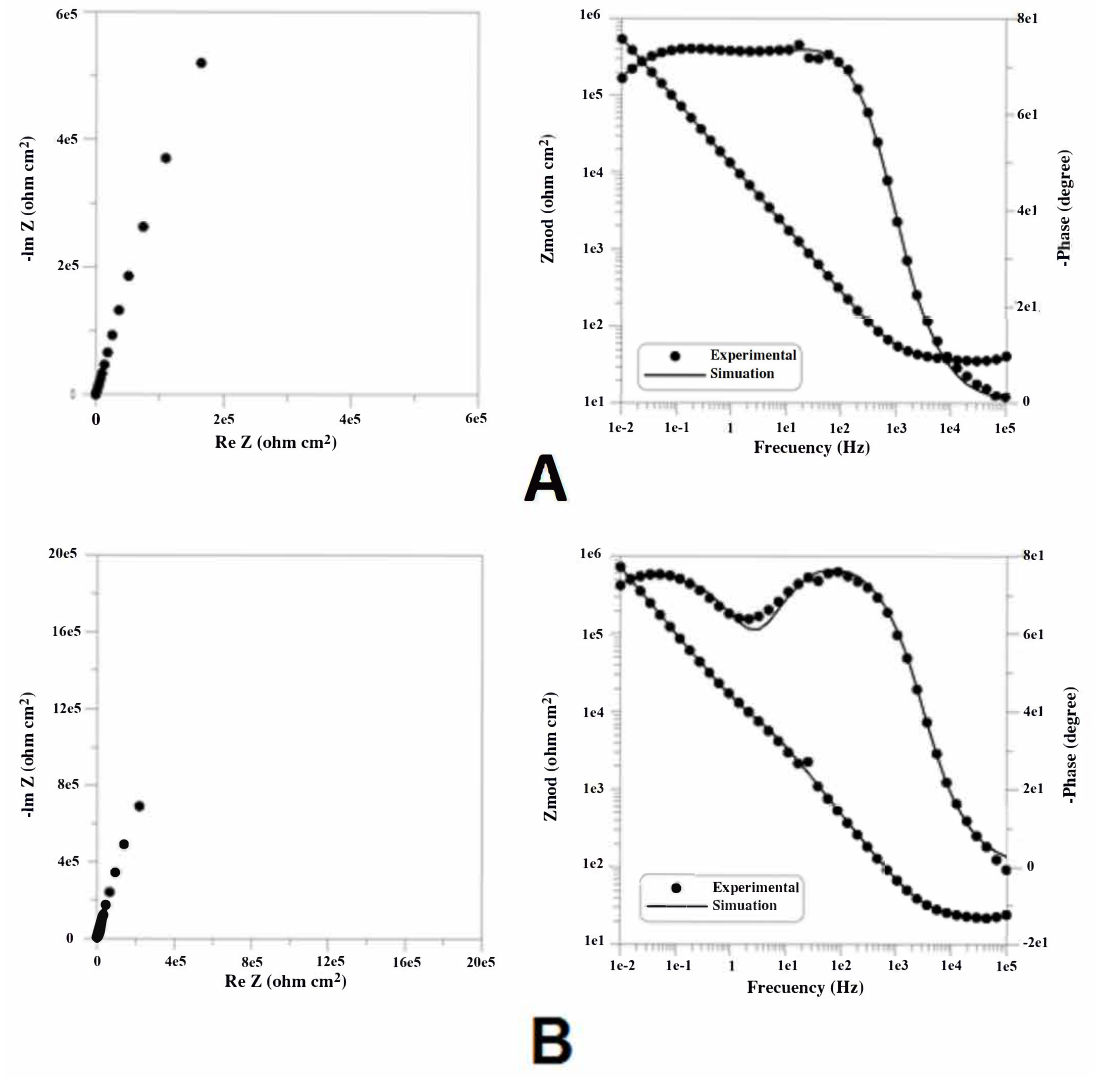
Figure 7. Bode spectra and Nyquist plot diagrams for CoCr-based dental alloys in Ringer solution at a potential of 100 mV/ESC. ( A ) Specimen Co1. ( B ) Specimen